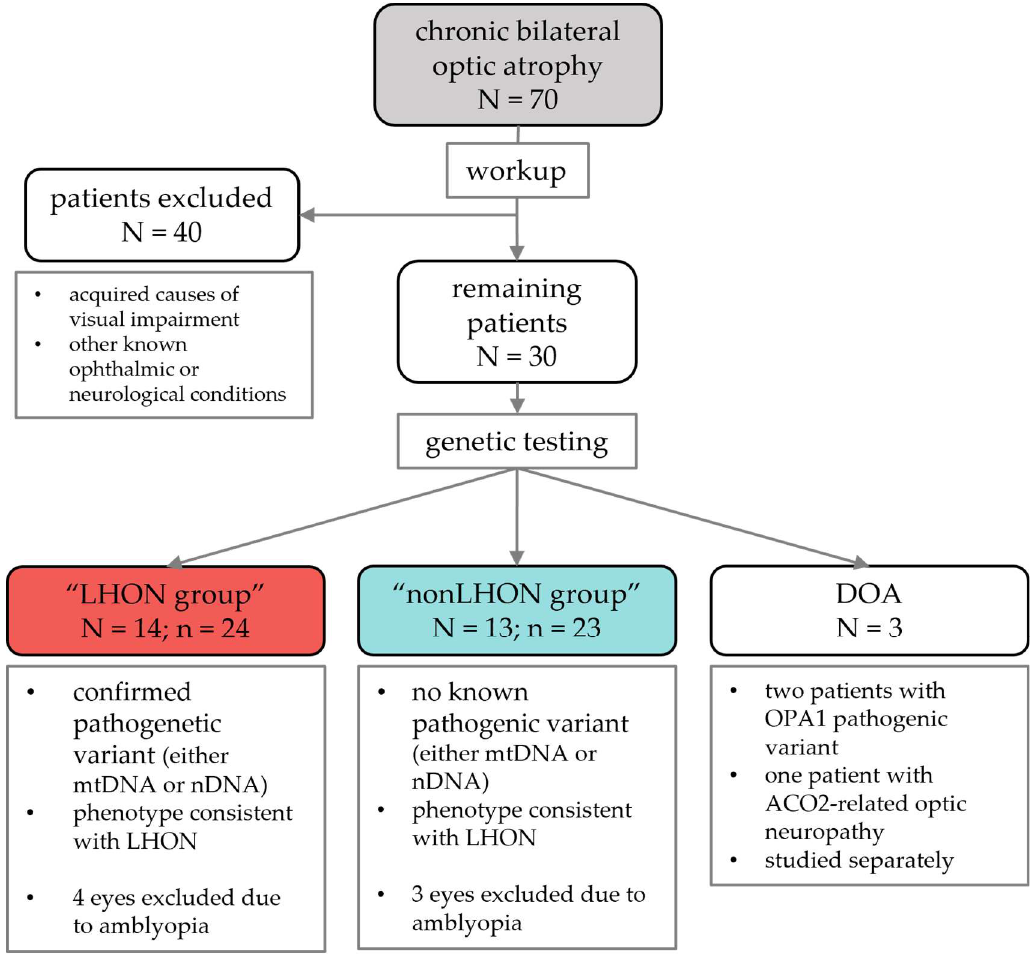
Figure 1. Flowchart of patient management. LHON—Leber hereditary optic neuropathy; DOA—dominant optic atrophy; mtDNA—mitochondrial DNA; nDNA—nuclear DNA; N—number of patients; n—number of eyes .